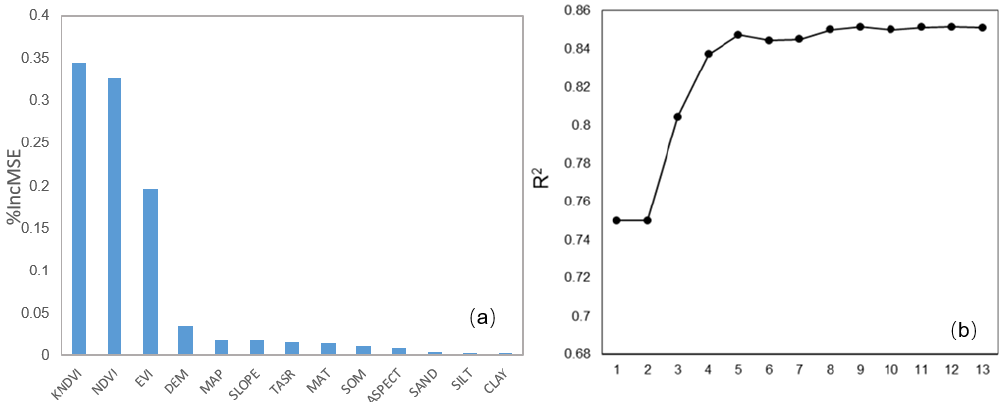
Figure A3. The important values for each independent variable (a) and the R 2 results of the different number of input variables at the MODIS pixel scale (b)